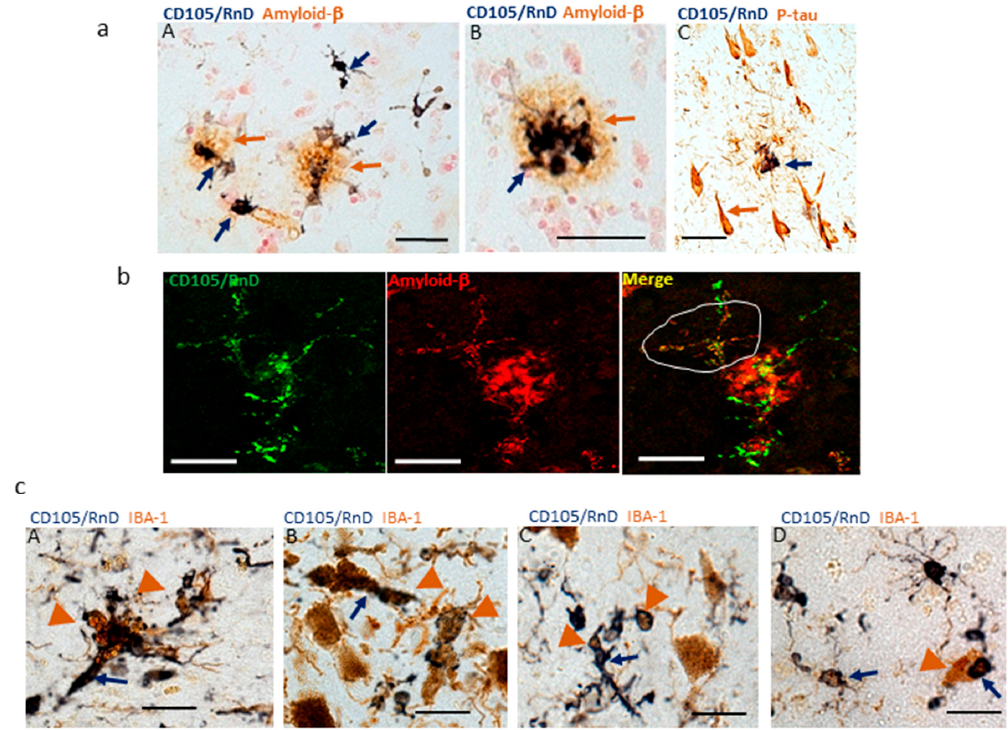
Figure 7. CD105 / MAB1097-positive microglia associated with pathological structures. ( a ) panels A–B). Strongly CD105-positive microglia were mainly associated with A β plaques (panels A, B) but not with phospho-tau positive neurofibrillary tangles (C). CD105 / RnD staining observed in p-tau positive neuritic plaque. Scale bars represent 50 µ m. ( b ) Confocal colocalization of CD105 and A β . Colocalization of CD105 / RnD (green) and A β (red) and merged image (yellow) demonstrated by confocal microscopy in AD case. The area delineated on Merge image encompasses a microglia with intracellular A β (yellow structures). Images are at the same magnification; scale bars represent 20 µ m. ( c ) CD105-positive microglia containing neuromelanin. Panels A–D) Strongly positive CD105 positive structures (purple arrows) associated with neuromelanin particles (arrowheads) in the substantia nigra. Panel A, Control case; Panel B, ILBD case; and panel C and D, PD cases. Images are at the same magnification; scale bars represent 50 µ